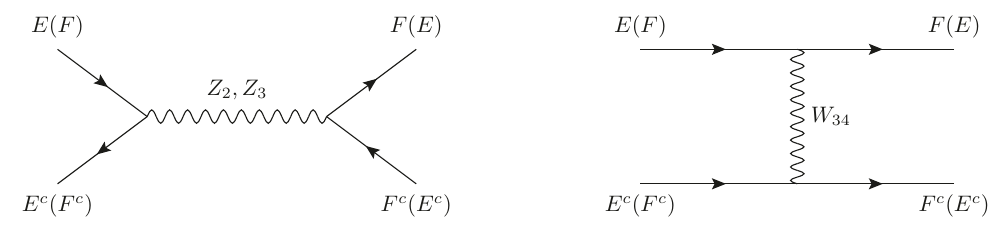
Figure 3 . Conversion between fermion dark matter